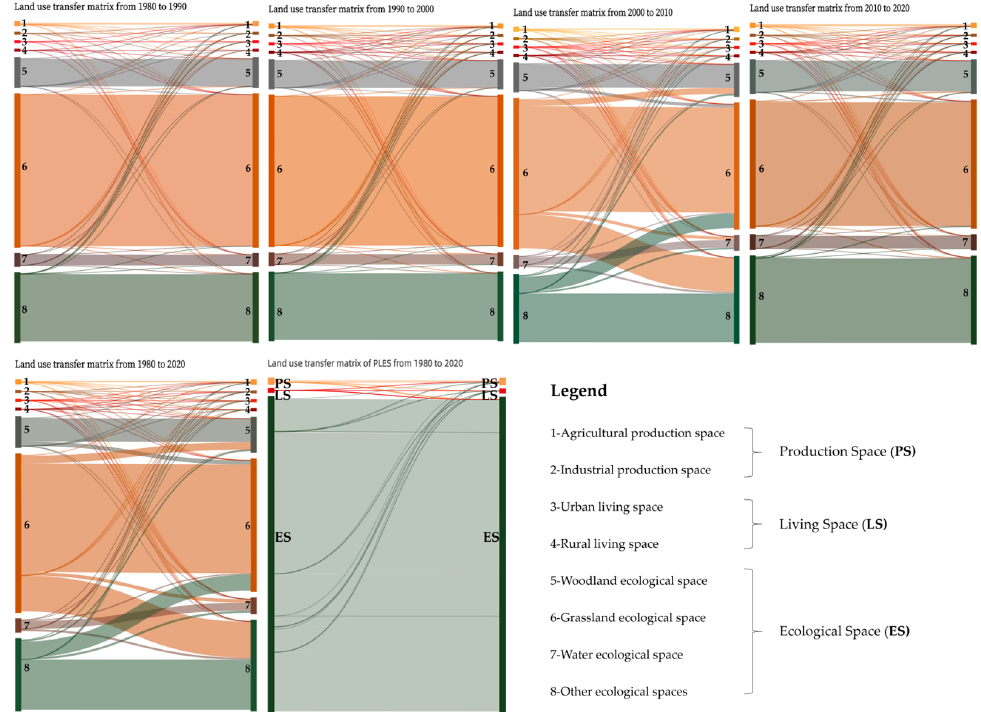
Figure 4. Transfer matrix of land use structure change from 1980 to 2020.